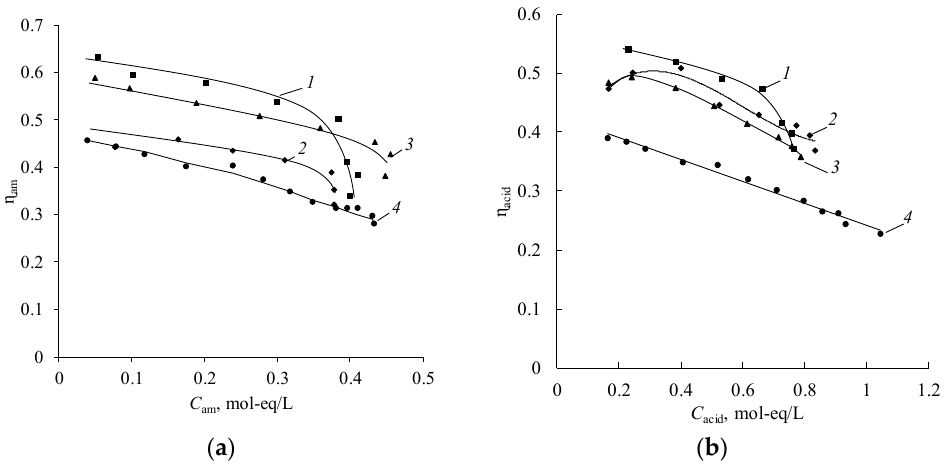
Figure 15. Concentration dependence of the integral current efficiencies of amines ( a ) and sulfuric acid ( b ) in the process of production: 1 —MA, 2 —DMA, 3 —EDA, 4 —DEA. The solid lines show the approximating curves.